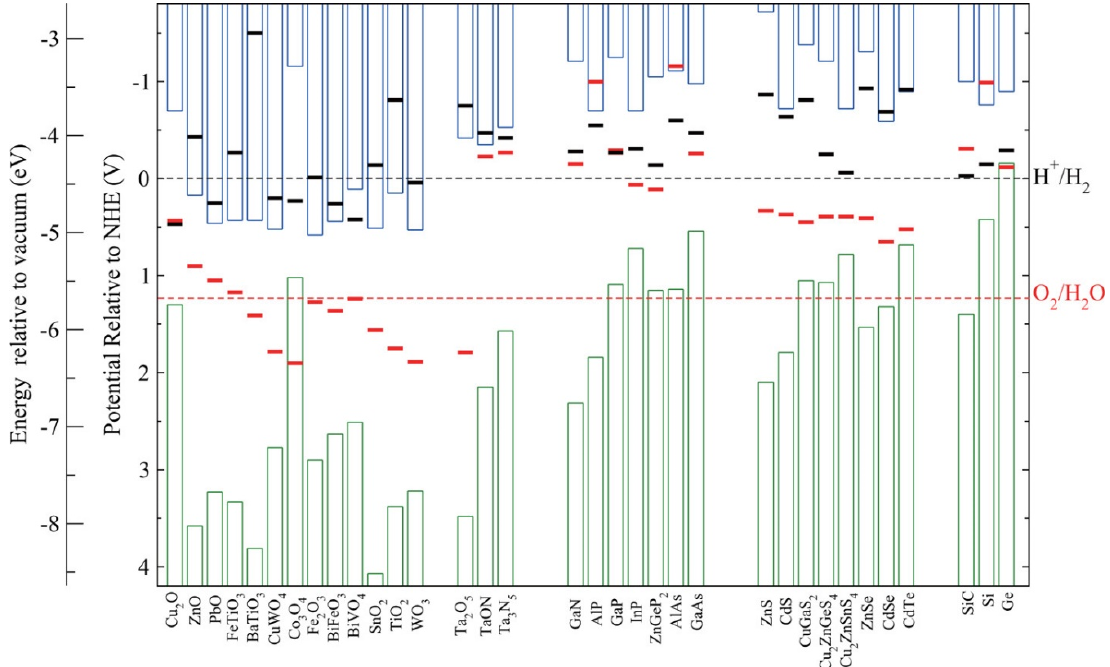
Figure 7. Comparison of band gap, band energies and redox potentials for different semiconductors for PEC-WS. Reprinted from [9] with the permission of the American Chemical Society.